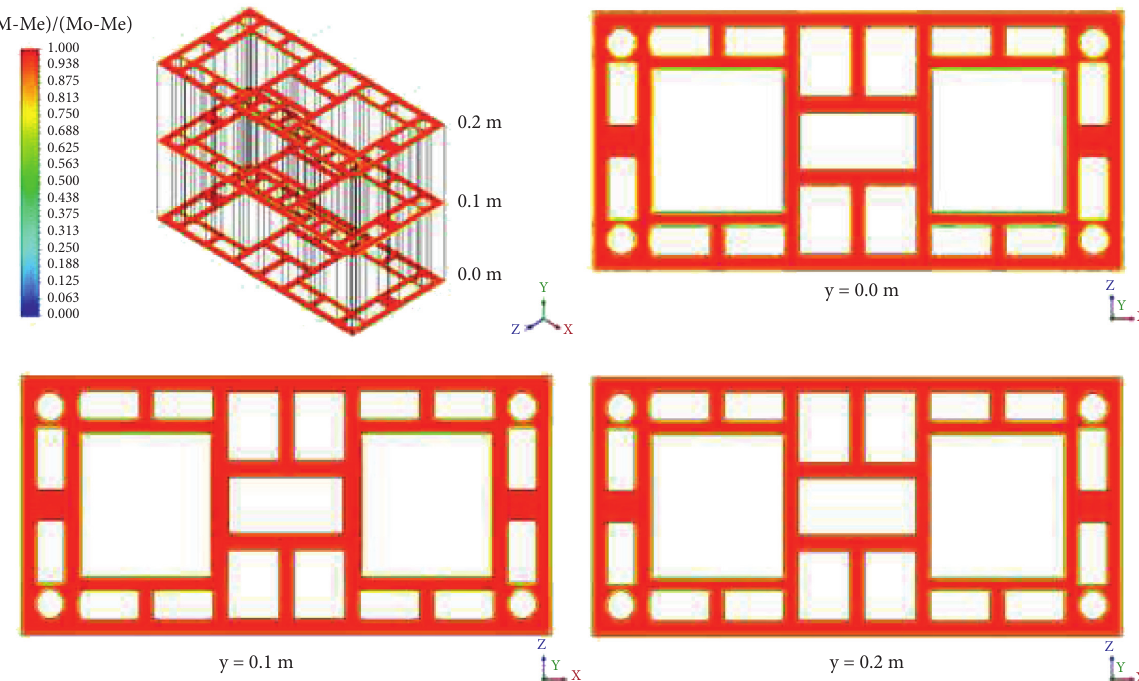
Figure 14: Dimensionless moisture field in the brick, at different planes XZ with the elapsed time of 10 minutes ( T � 80 ° C, RH � 5%). (M-Me)/(Mo-Me)